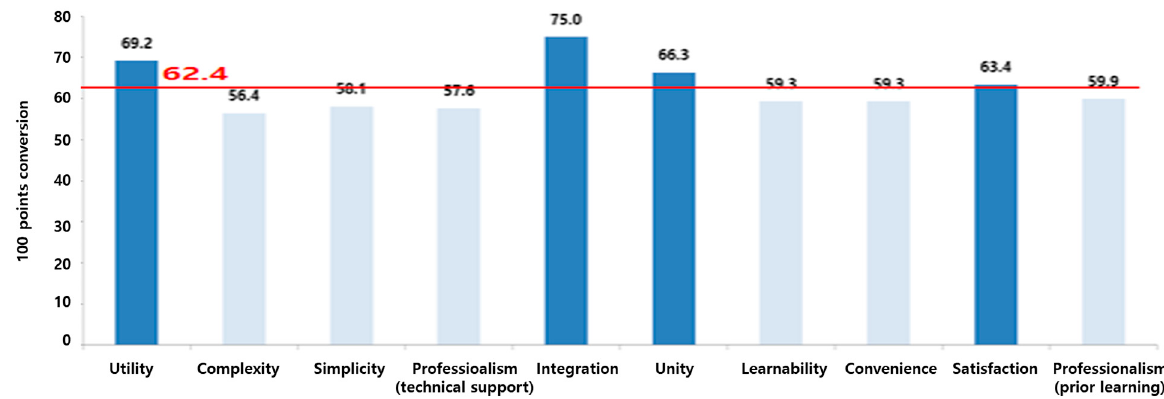
Figure 4. SUS item scores (Converted to a scale of 100). Table 5. SUS evaluation results. (N = 43, Unit: point).